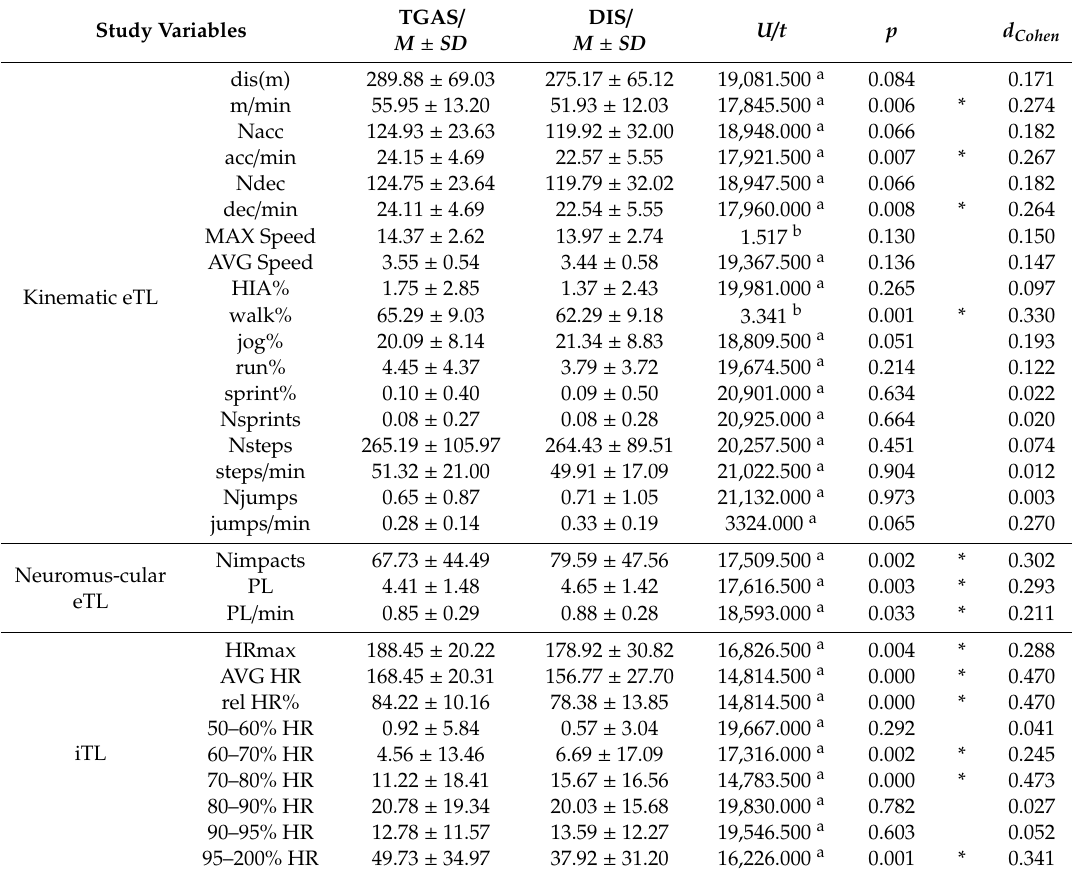
Table 4. Results of the assessment tests according to teaching